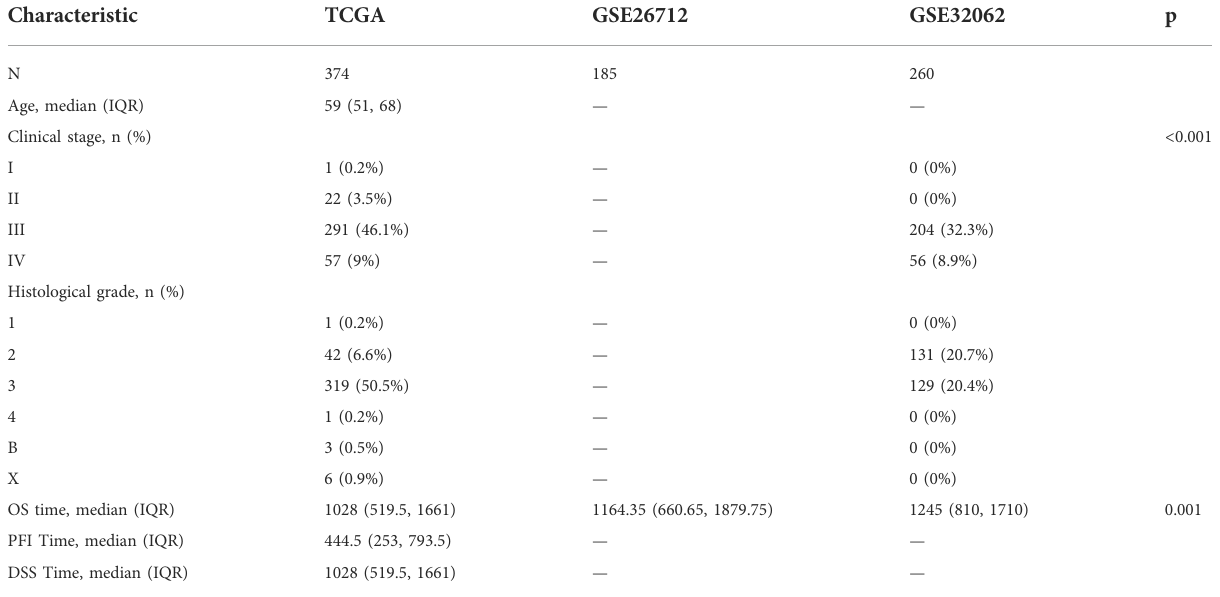
TABLE 1 Baseline clinical characteristics of the patients with OC in this study.